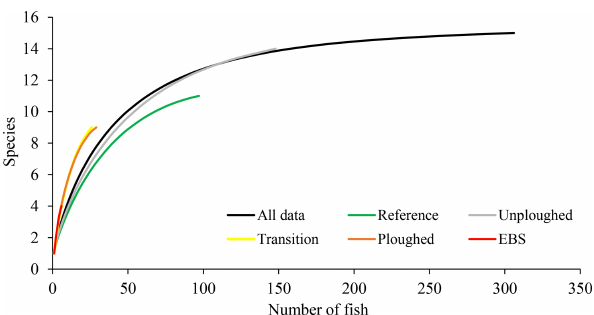
Figure 3. Rarefaction curves, estimated species richness as a func- tion of the number of fish observations, for OFOS transects across habitat